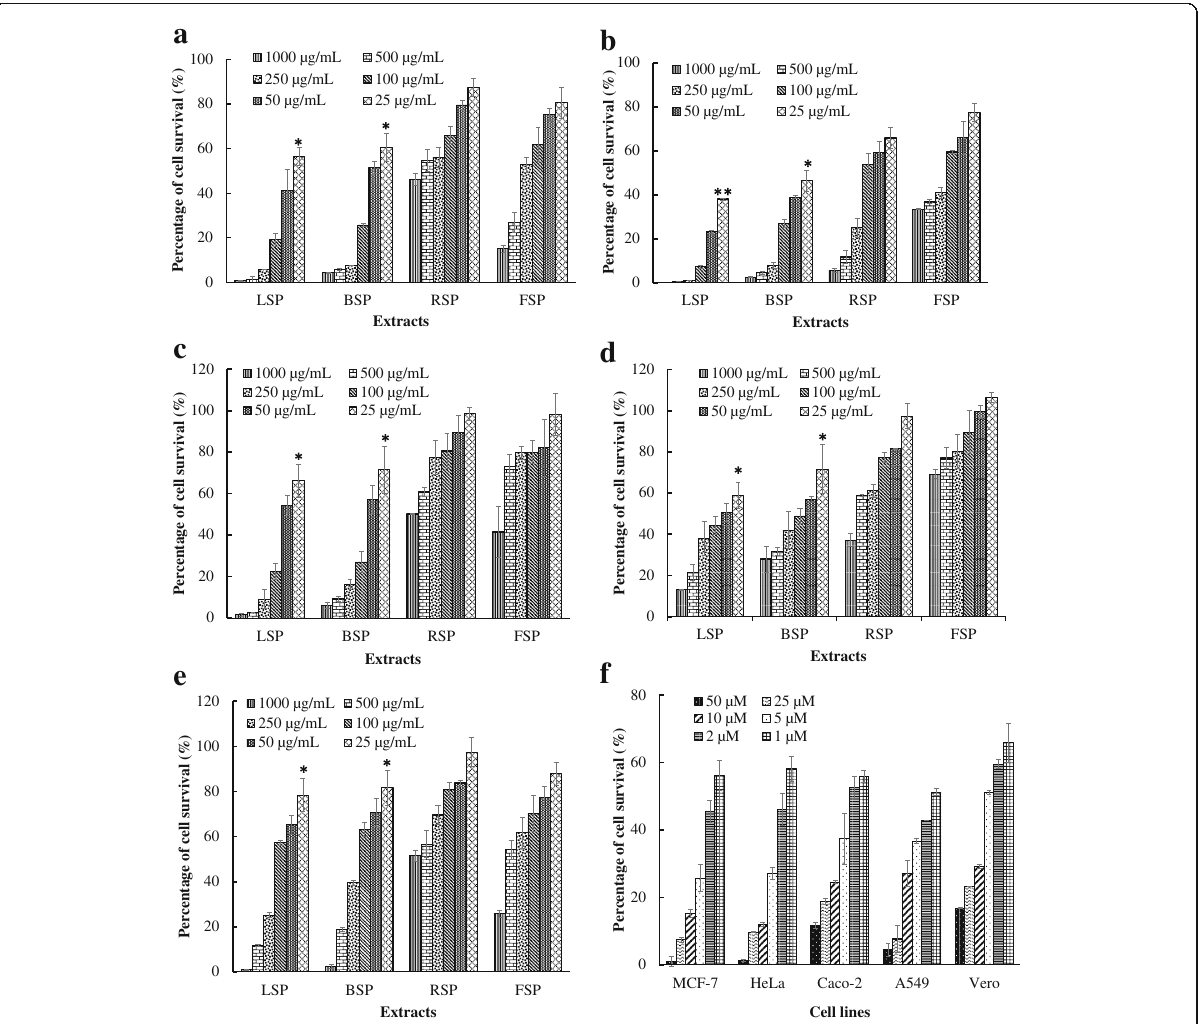
Fig. 2 Antiproliferative activity of Sarcocephalus pobeguinii extracts against MCF-7 ( a ), HeLa ( b ), Caco-2 ( c ), A549 ( d ) and Vero ( e ) cell lines compared to the cytotoxic effect of doxorubicin on these cells lines ( f ). Data represent the mean ± SE (standard error) of three independent experiments. LSP: Methanol extract from leaves of S. pobeguinii , RSP: Methanol extract from roots of S. pobeguinii , FSP: CH 2 Cl 2 /MeOH (1:2) extract from fruits of S. pobeguinii , BSP: Methanol extract from bark of S.